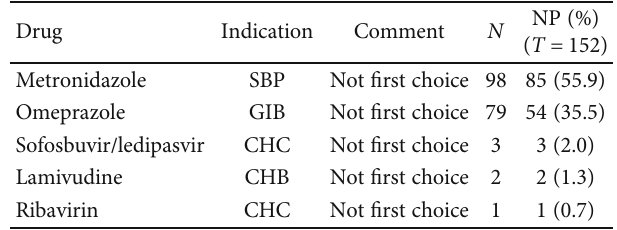
Table 4: Prescriptions not compliant with pharmacotherapy guidelines for indication ( n = 183 ).